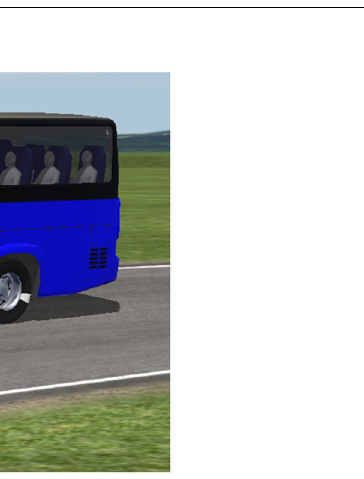
Fig 5. Three-dimensional mechanical model of large bus of TruckSim.